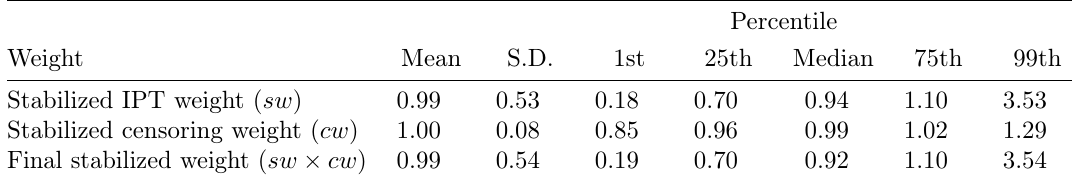
Table 3: Stabilized Inverse Probability of Treatment (IPT), Censoring, and Final Weights